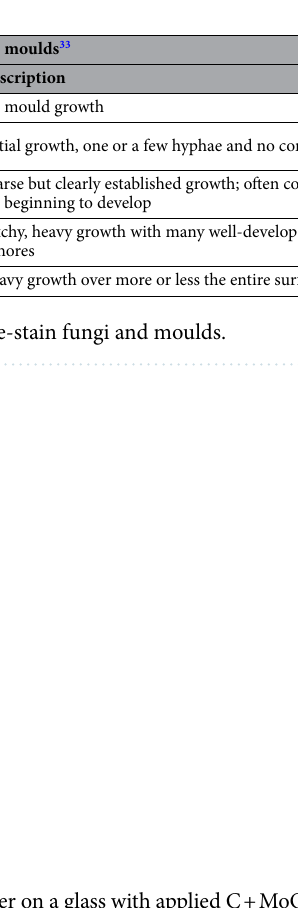
Figure 2. Damping times determined with pendulum hardness tester on a glass with applied C + MoO 3 films with different wet film thicknesses and on uncoated